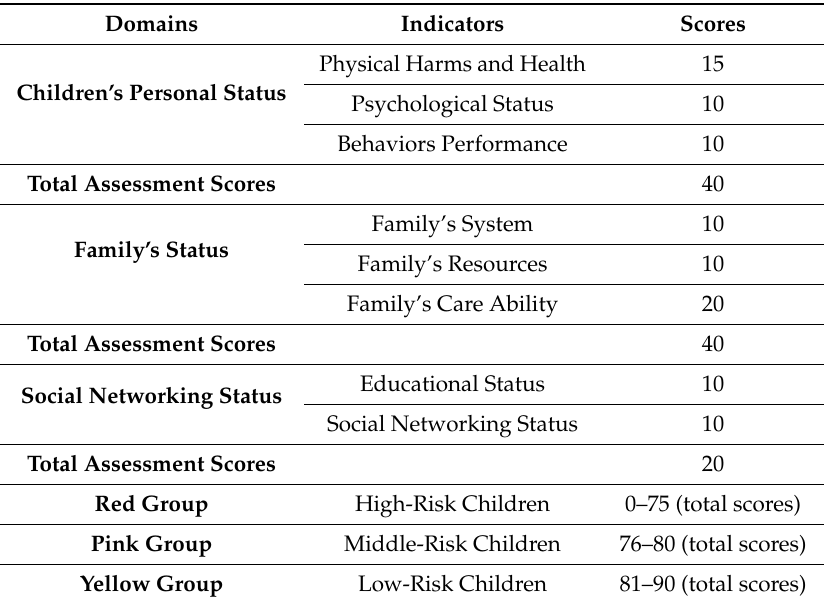
Table 2. Assessment Instrument of Agency L.